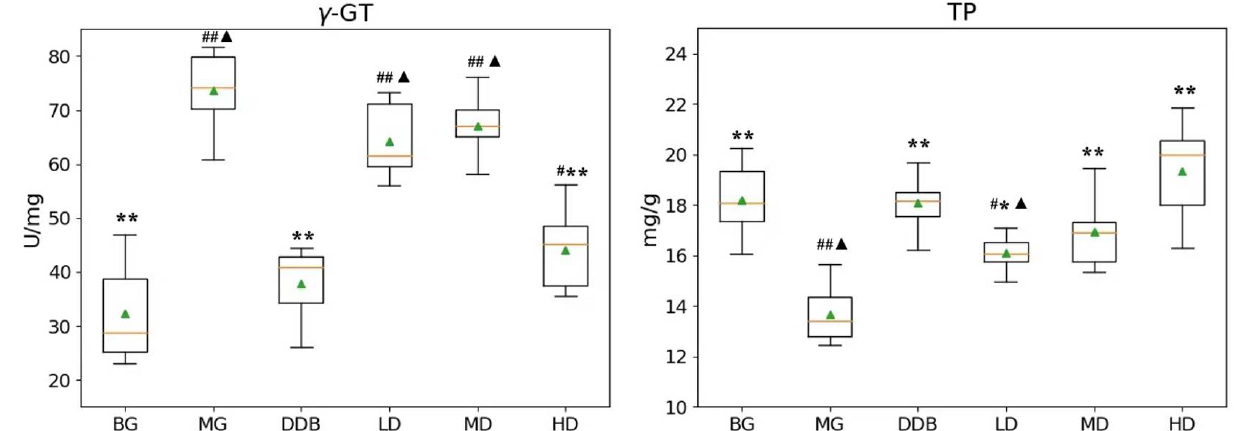
Figure 4. Effects of SBS on γ-GT and TP in liver tissue. Data are presented as mean ± S.E.M. ( n = 10). Significant differences compared with the BG group were designated as # p < 0.01 and ## p < 0.05, with the MG group as * p < 0.05 and ** p < 0.01, and with the DDB groups as ▲ p < 0.05.